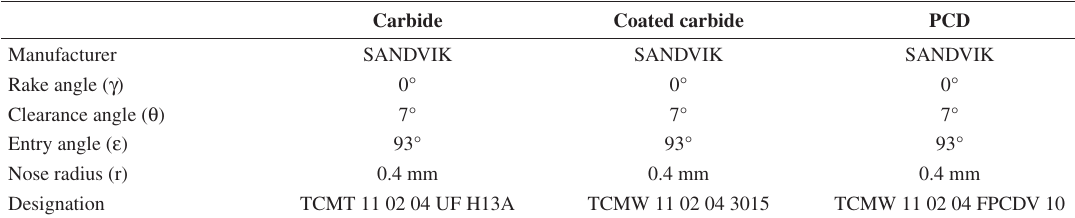
Table 1. Details of tools used for turning.